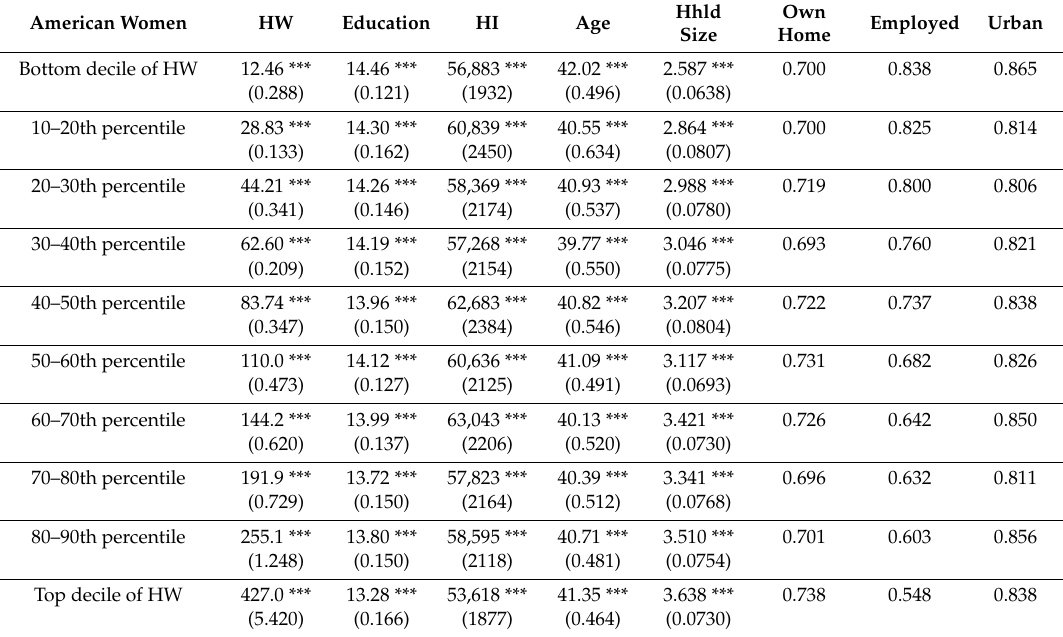
Table 2. Pooled descriptive statistics, 20 to 60-year-old women, US